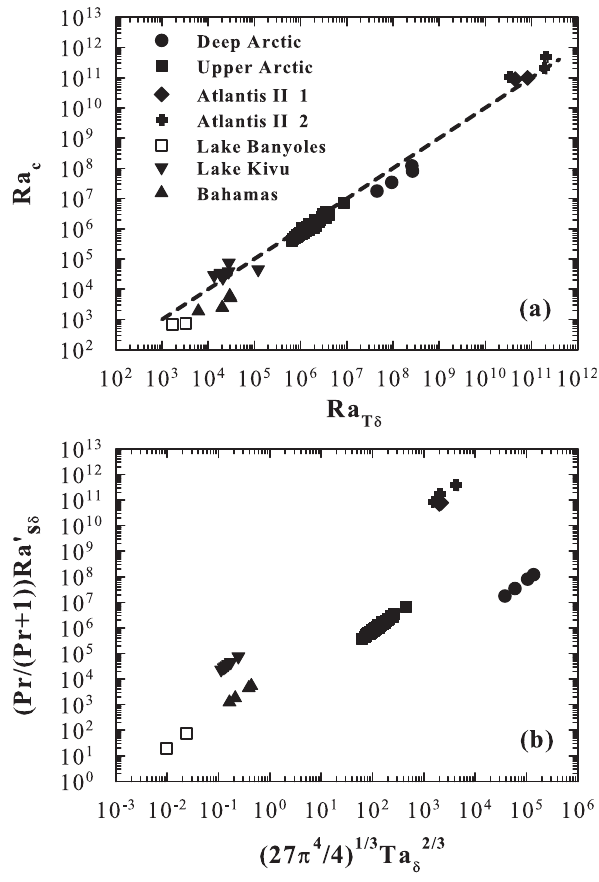
Fig. 5. (a) Comparison between the calculated onset thermal Rayleigh number, Ra c , based on Eqs. (5) and (6) and the bound- ary layer thermal Rayleigh number, Ra T δ . (b) Comparison be- /(Pr + 1 ) , and the second term, tween the first term, PrRa 0 S δ ( 27 π 4 / 4 ) 1 / 3 T a 2 / 3 , in Eq. δ